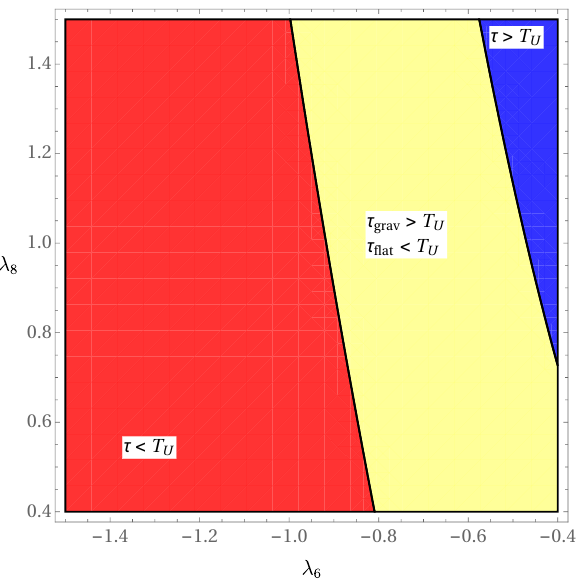
Figure 3 . Stability diagram in the ( (cid:21) 6 ; (cid:21) 8 ) plane showing three separate regions where: (i) (cid:28) (cid:13)at ; (cid:28) grav > T U (blue region); (ii) (cid:28) (cid:13)at < T U , (cid:28) grav > T U (yellow region); (iii) (cid:28) (cid:13)at ; (cid:28) grav < T U (red region). Note that, as in the blue (red) area (cid:28) (cid:13)at and (cid:28) grav are both larger (smaller) than T U , in these regions we wrote (cid:28) > T U ( (cid:28) < T U ) with no further speci(cid:12)cation. The potential of (2.25) and parameters (cid:21) (cid:3) , (cid:11) , (cid:12) given in (2.19) are used. Note that although the inclusion of gravity induces an enlargement of the region with EW vacuum lifetime larger than T U , for a large portion of the phase diagram we have (cid:28) < T U , even when gravity is taken into